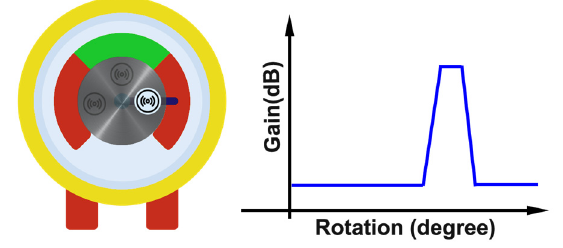
Figure 3 . analog manometer conceptual solution design